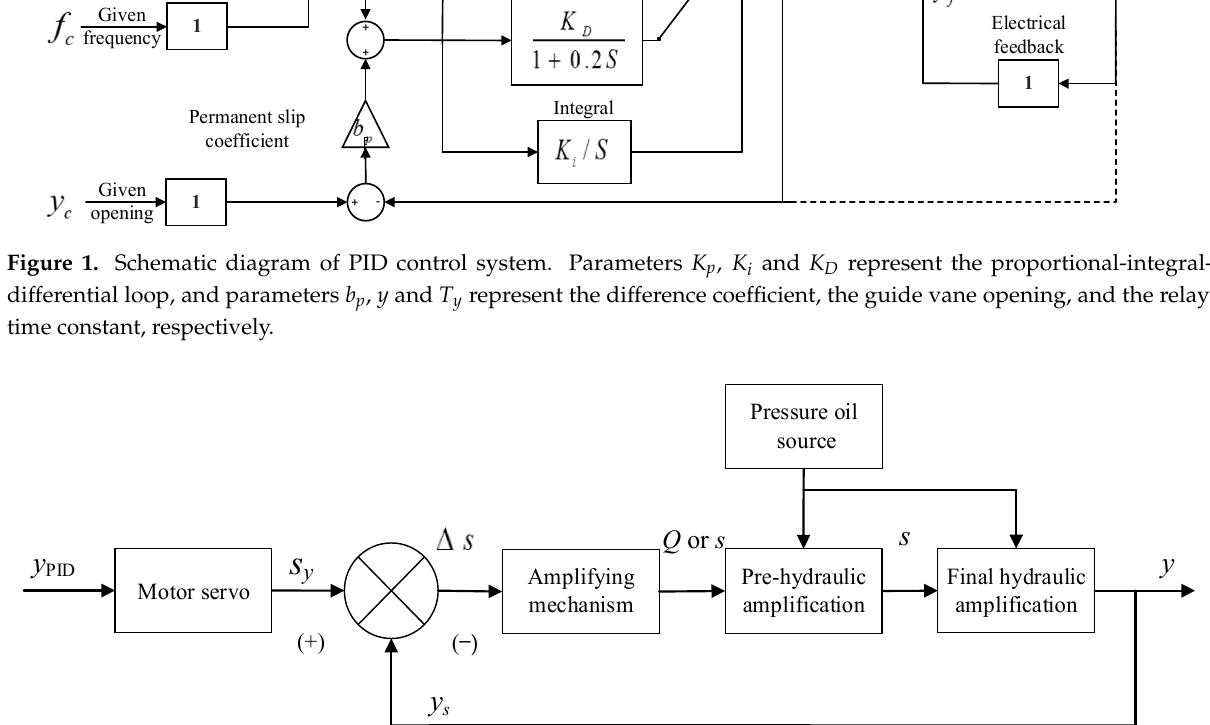
Figure 2. Working diagram of the hydro-mechanical system defined by the transfer functions. Parameters y PID , s y , y s and y represent the microcomputer regulator output signal, the feedback signal, the mechanical displacement signal and the guide vane opening.